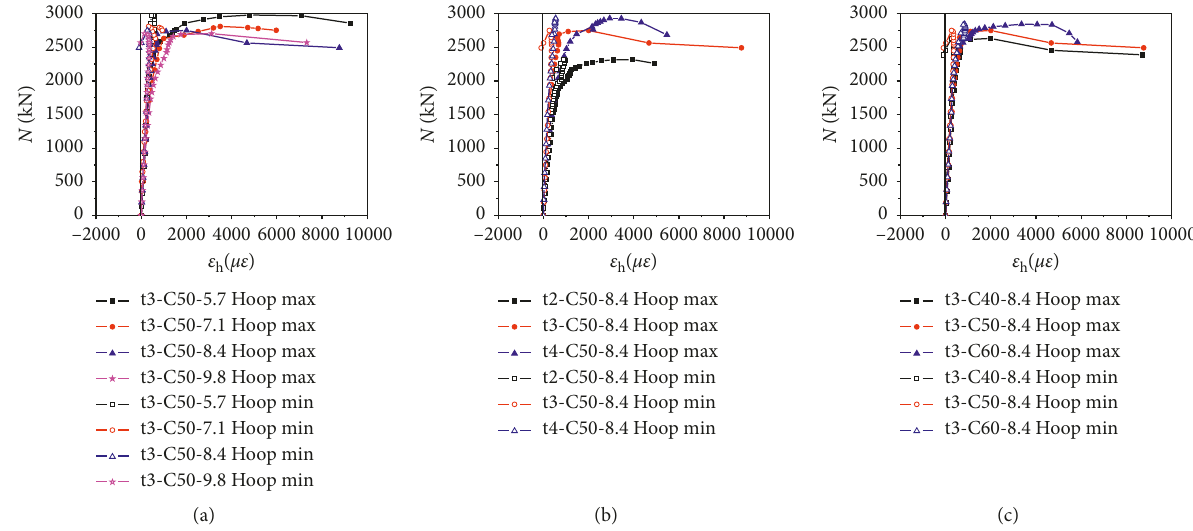
Figure 6: Axial load-hoop strain of outer steel tube response. (a) L / D ratio. (b) D / t ratio. (c) SCC strength.